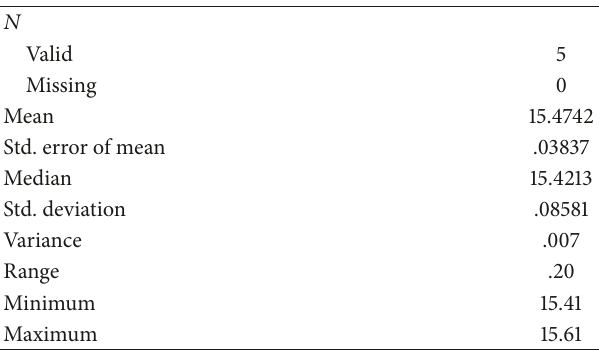
Table 7: Statistical results of reactor outlet pressure.